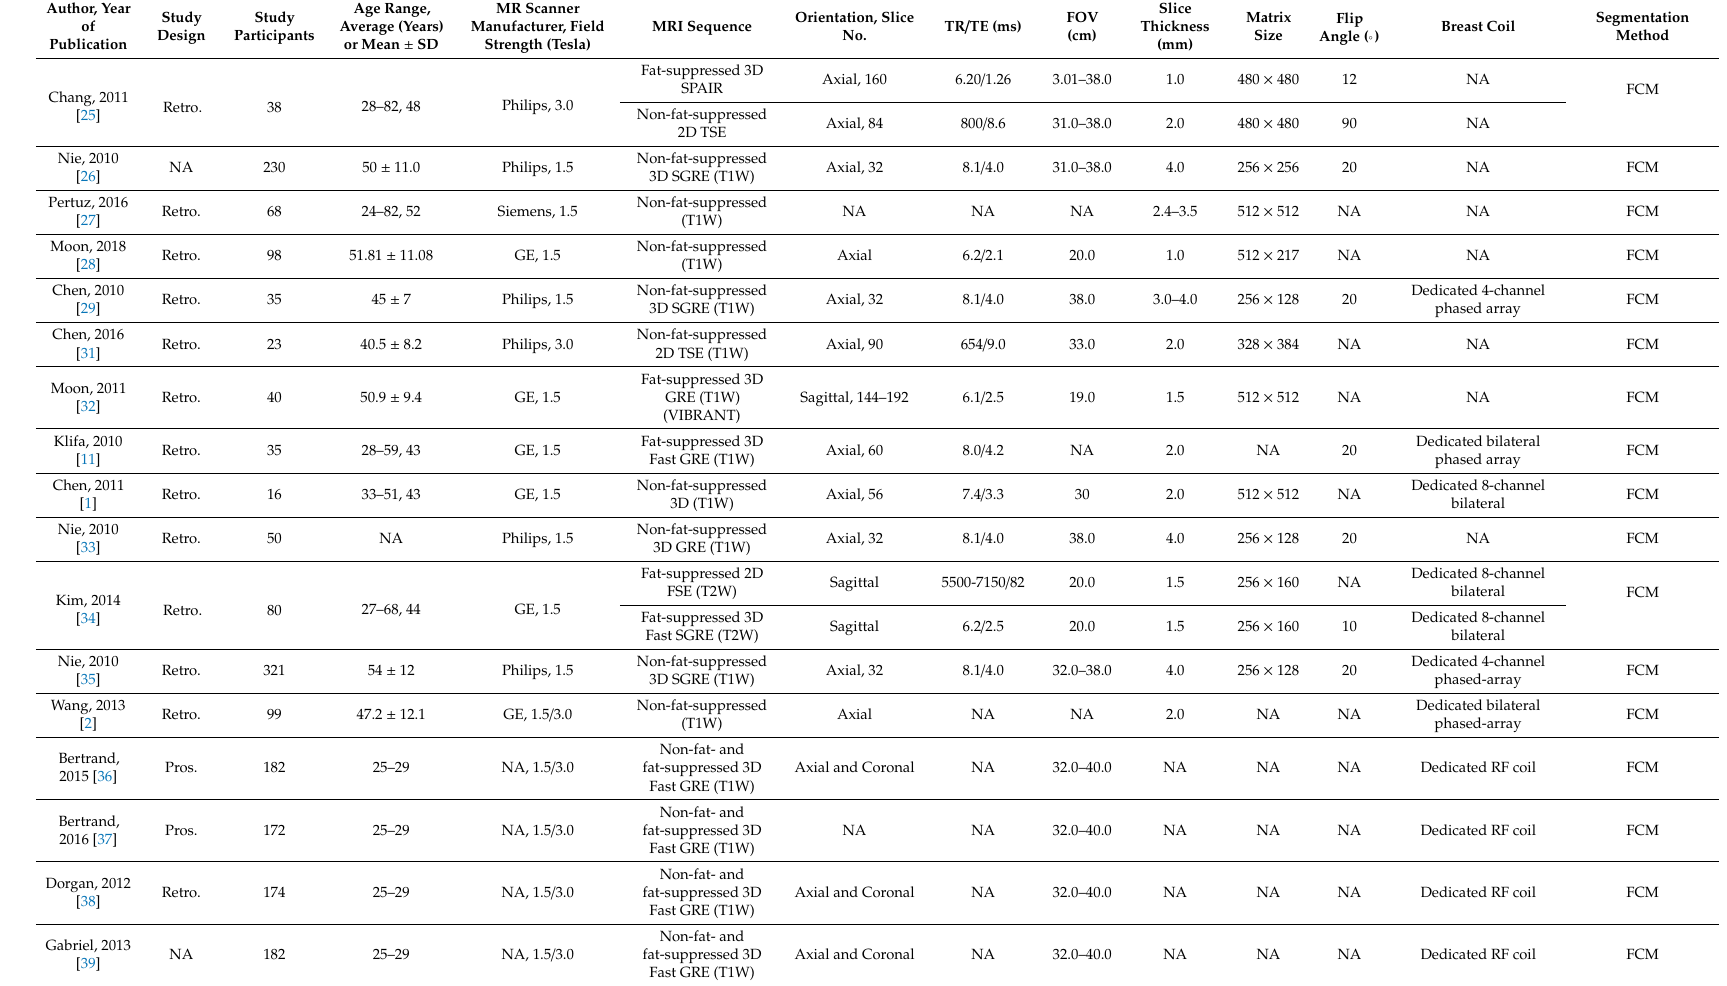
Table 1. Characteristics of the included studies in the systematic review and